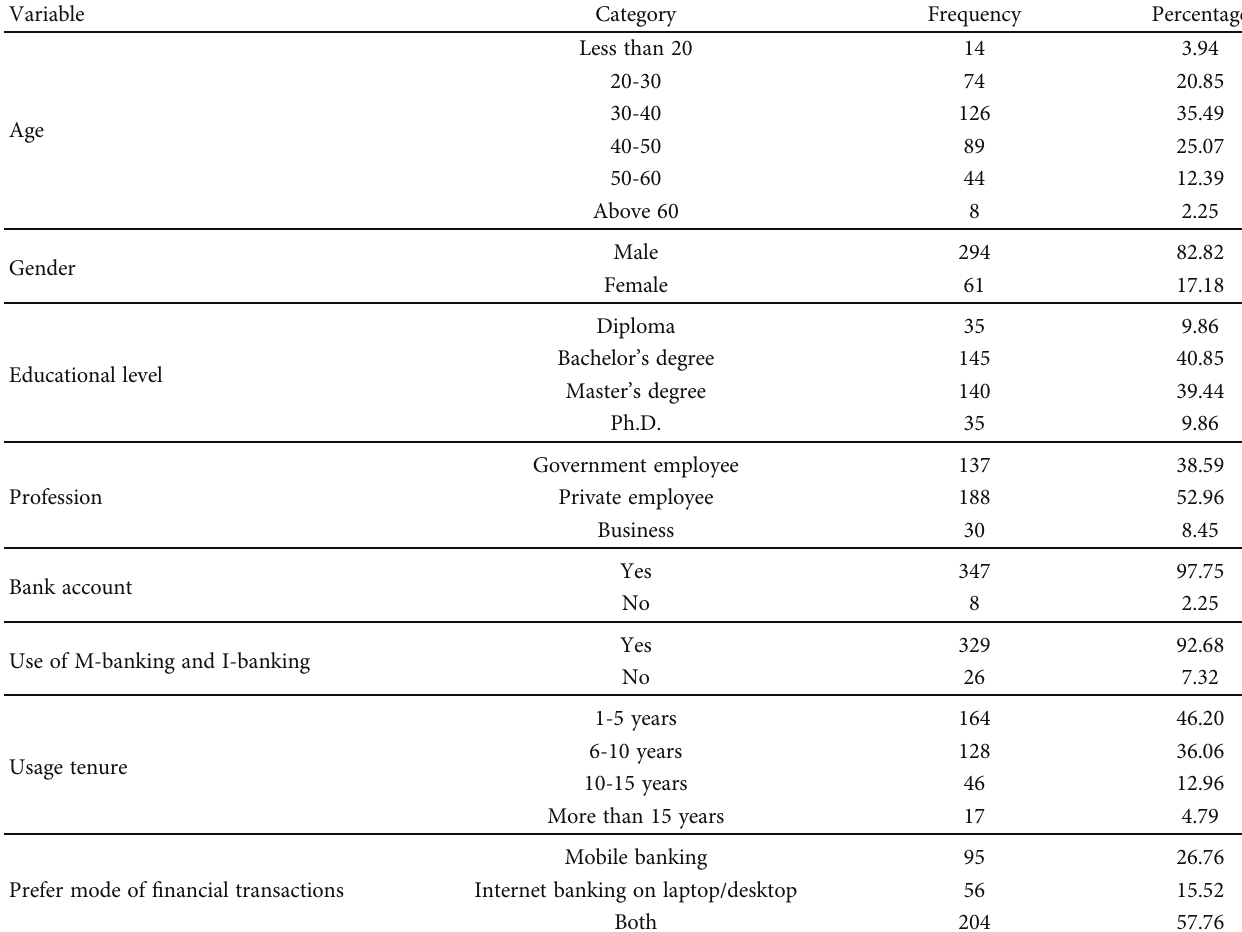
Table 1: Demographic pro fi le of the respondents.